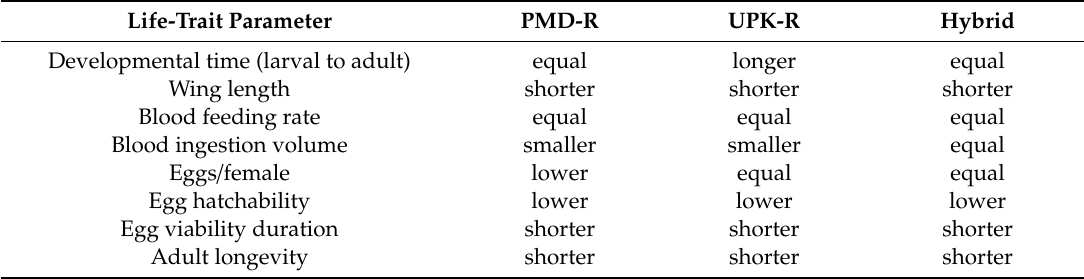
Table 3. Summary of relative fitness cost on life-trait parameters of the pyrethroid-resistant PMD-R and UPK-R strains and F 1 (PMD-R × UPK-R) hybrid compared with the pyrethroid-susceptible PMD